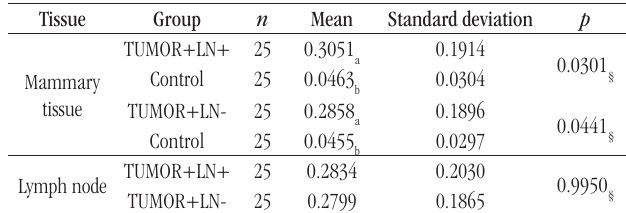
taBLE 5 − Evaluation of ratio between cell proliferation by Ki-67 (cell proliferation) and caspase 3 (apoptosis) in the mammary tissue among the different groups studied